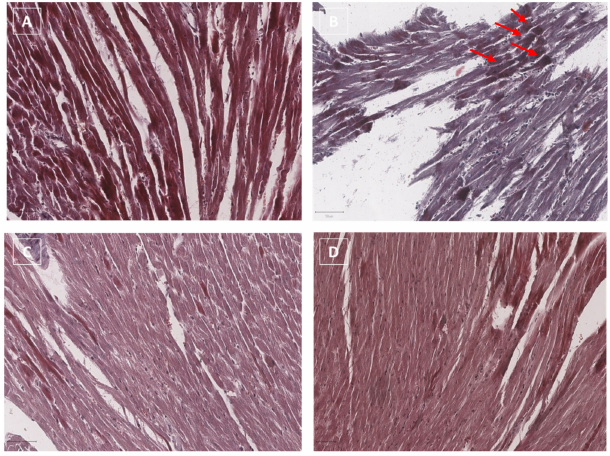
Figure 8. Masson’s trichrome staining in myocardial tissues of mice untreated (saline), ( A ) treated with DOXO ( B ) or Singo ( C ) or both in combination ( D ). Scale bar: 20 µ m. Red arrows indicate the points of greatest fibrosis induced by the treatment with